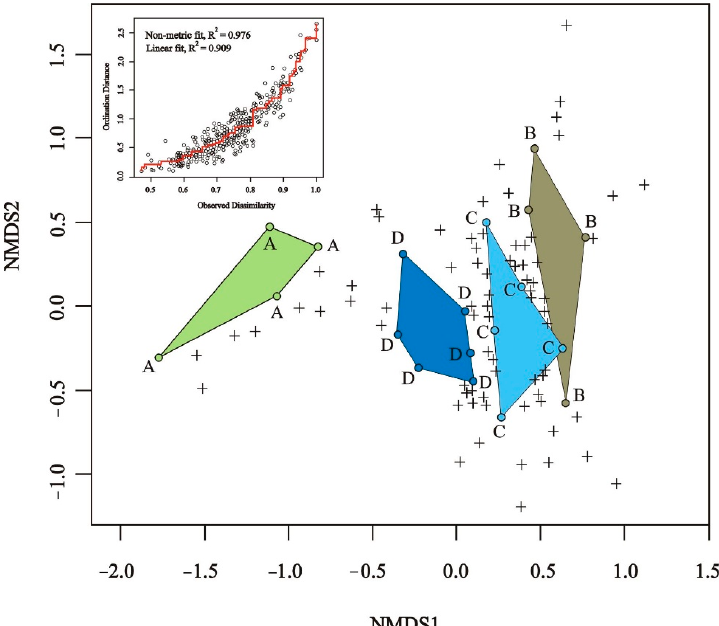
Figure 3. Non-metric multidimensional scaling: diagram showing similarity (Bray–Curtis index) of wild bee community structure for 4 habitat types: A = forests (green); B = clearings (olive); C = infil- tration ditches (sky-blue); D = infiltration basins (navy blue).